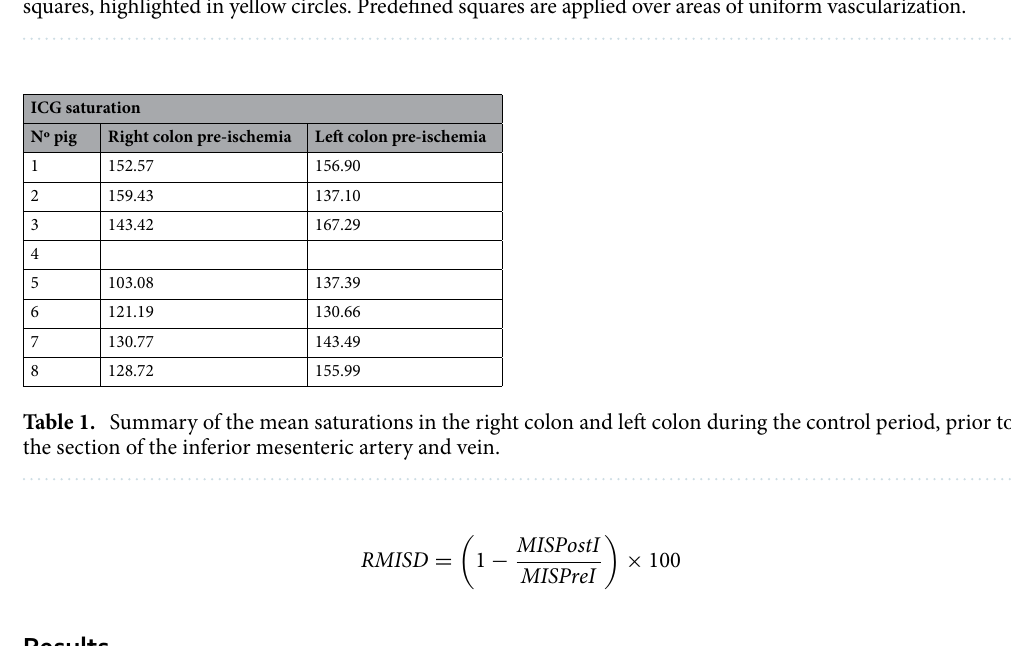
Figure 3. Ten areas of study of vascularization in the right colon (1) and in the left colon (2) using 10 × 10 pixel squares, highlighted in yellow circles. Predefined squares are applied over areas of uniform vascularization.